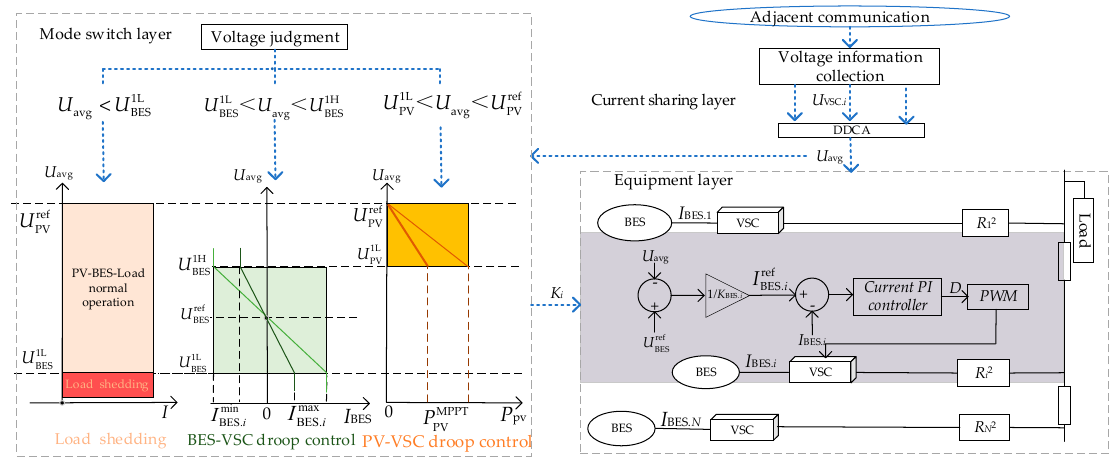
Figure 3. The hierarchical, coordinated control strategy of an island DC microgrid based on a multi-mode smooth switch.